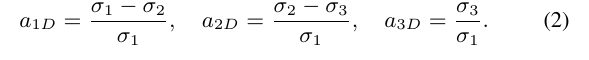
Figure 1: Entropy E ∗